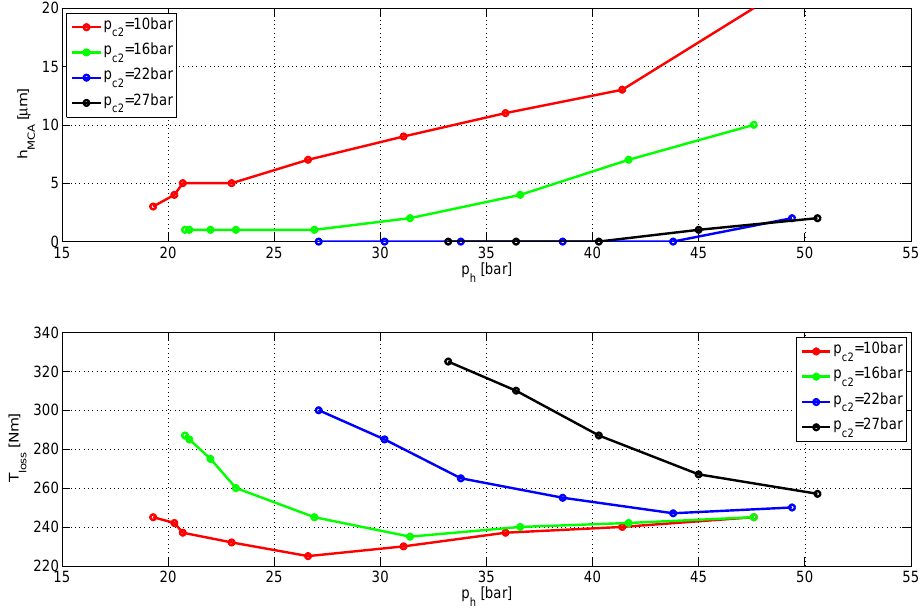
Figure 5: The measured deflections of the inner housing h MCA (top graph) and the measured torque losses T loss (bottom graph). Both are plotted with respect to the high pressure p h